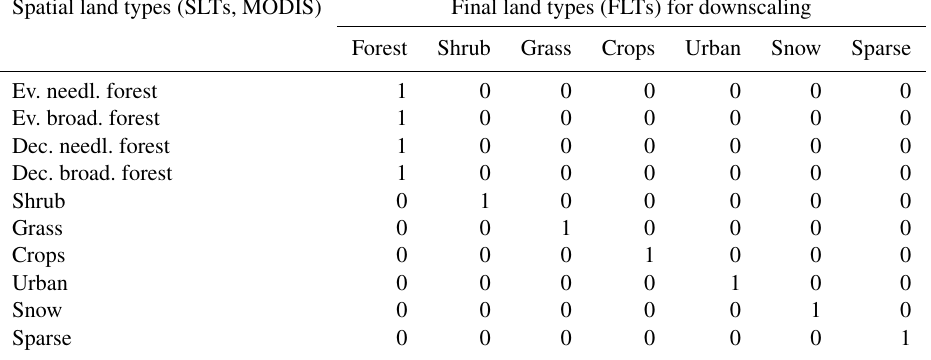
Table 2. User-defined aggregation of the spatial data. Spatial land types (SLTs, rows) are attributed to the final land types (FLTs, columns) identified by the number 1. For example, all MODIS forest types are here attributed to the forest FLT. Numbers between 0 and 1 can be used to aggregate a given SLT into several FLTs (e.g., a mosaic of crops and forests SLT could be split into the forest and crop FLTs using the values 0.5; see Sect.